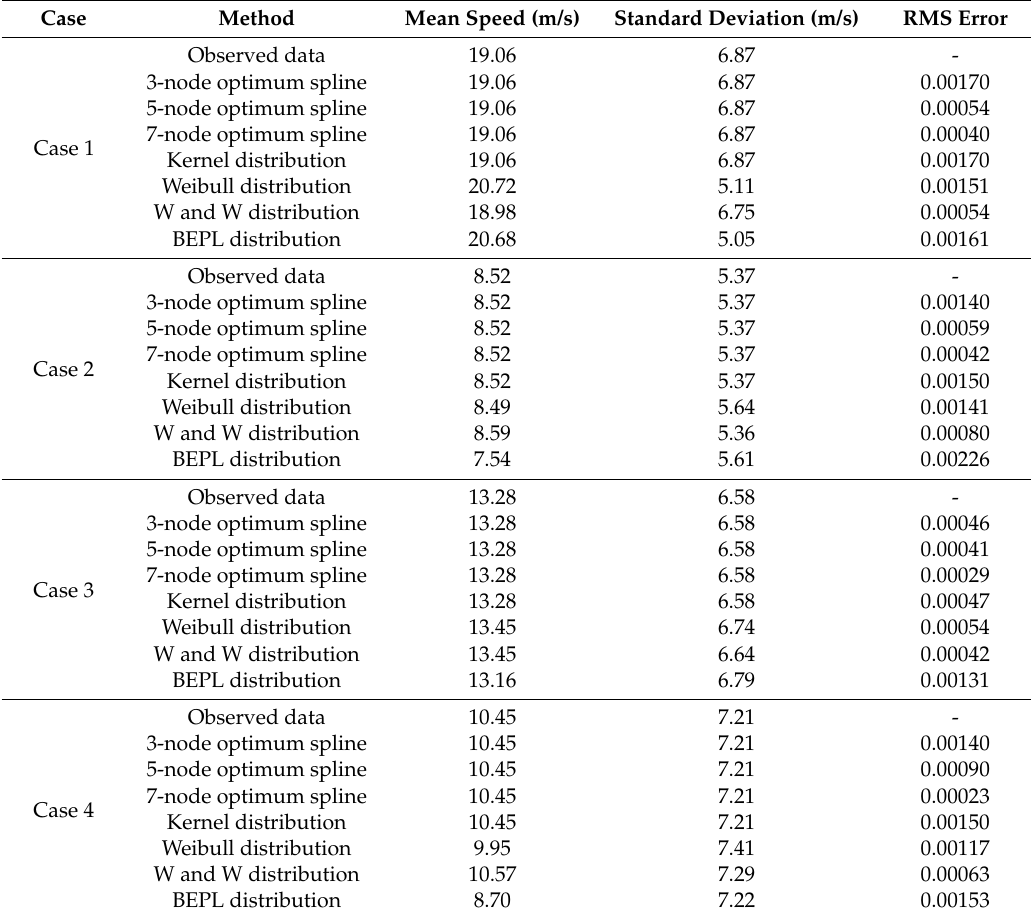
Table 2. Fitting results for the analyzed